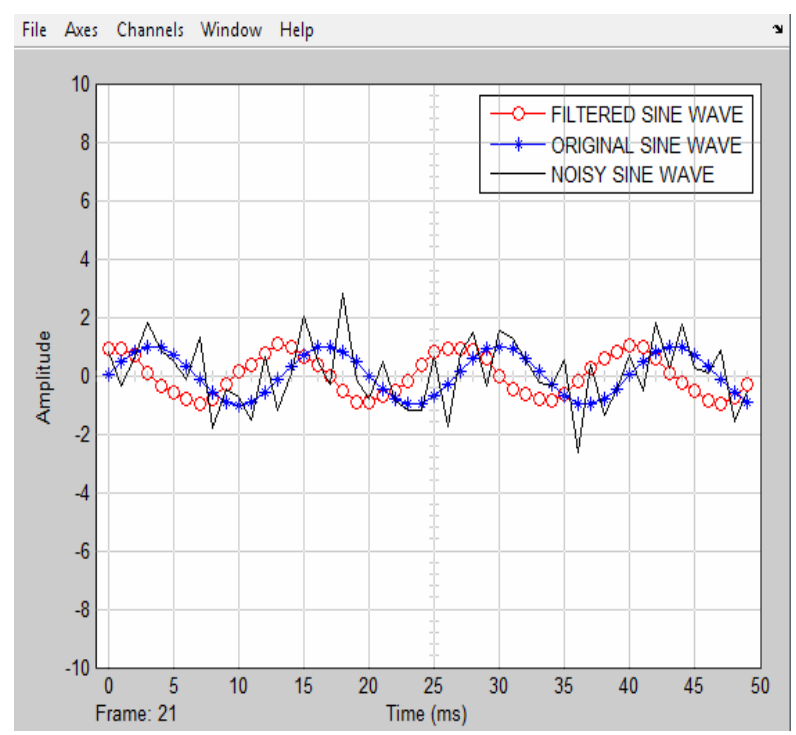
Figure 10. The original sine wave, noisy sine wave and the filtered sine wave used in the Simulink model